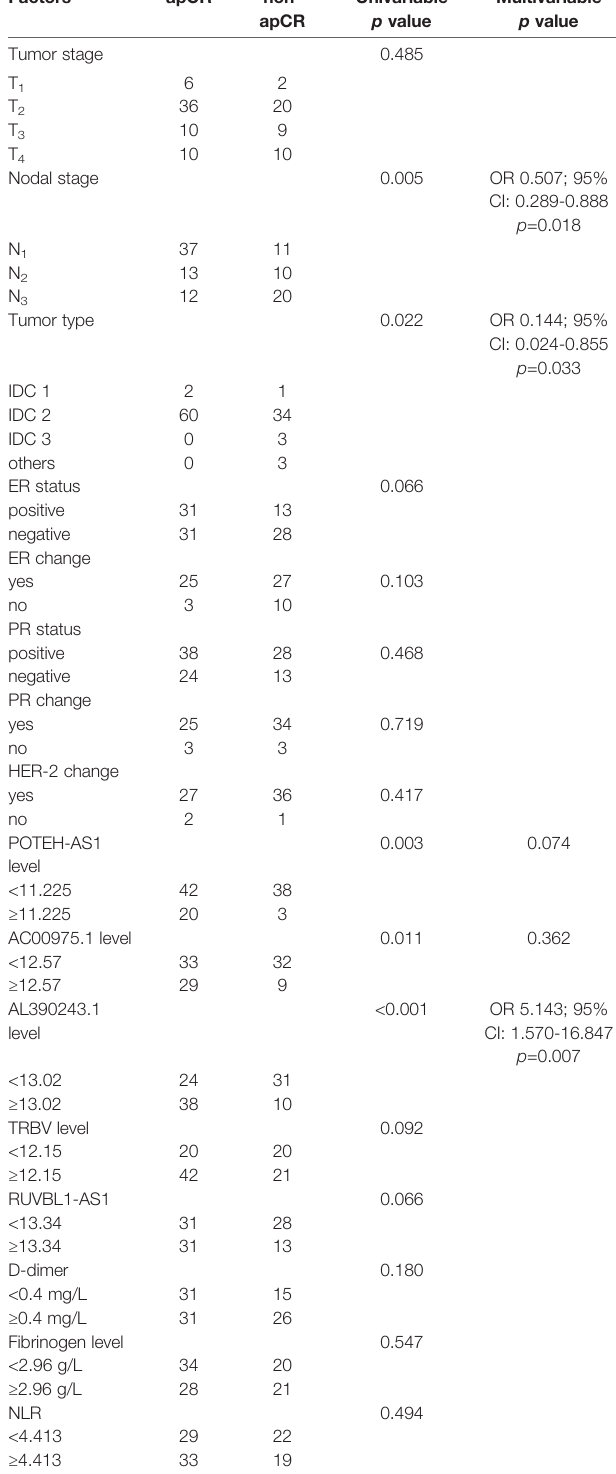
TABLE 4 | The logistic regression analyses of apCR after